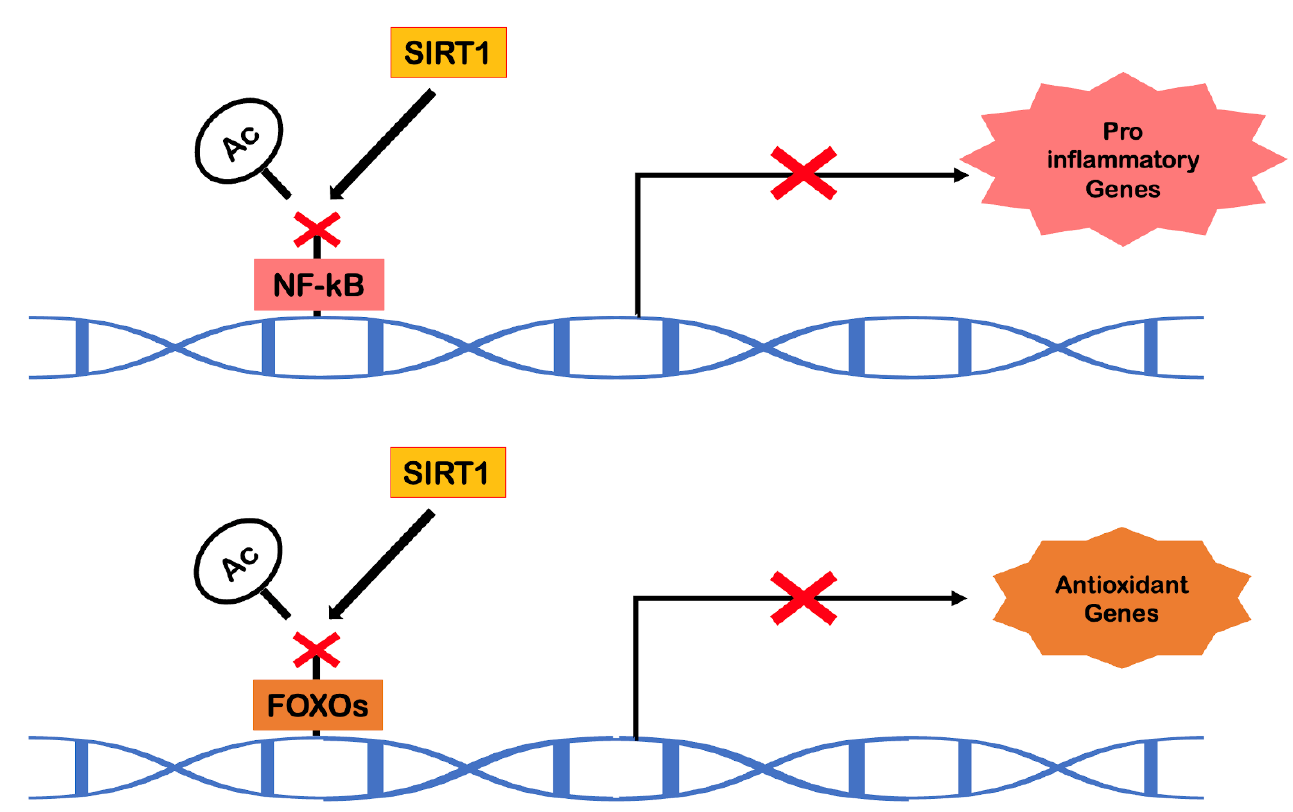
Figure 7. Transcriptional modulation of SIRT1 (adapted from Cheng et al. [64]). Abbreviations: Ac, acetylation; FOXO, forkhead box O; NF-kB, nuclear factor kappa B; SIRT1, sirtuin 1.